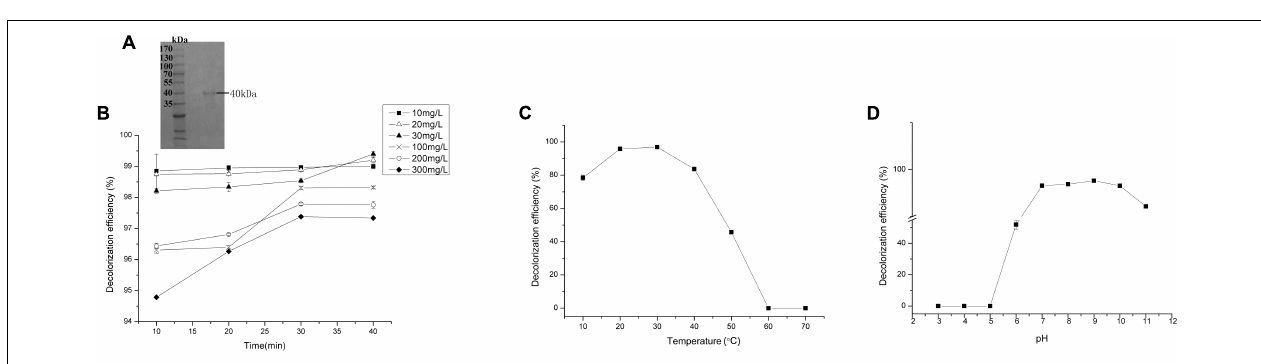
FIGURE 3 | Malachite green (MG) degradation characteristics of Mgv-rPOD. (A) SDS-PAGE result of Mgv-rPOD. (B) The effect of MG concentration on the MG decolorization efficiency of Mgv-rPOD. (C) The effect of temperature on the MG decolorization efficiency of Mgv-rPOD. (D) The effect of pH on the MG decolorization efficiency of